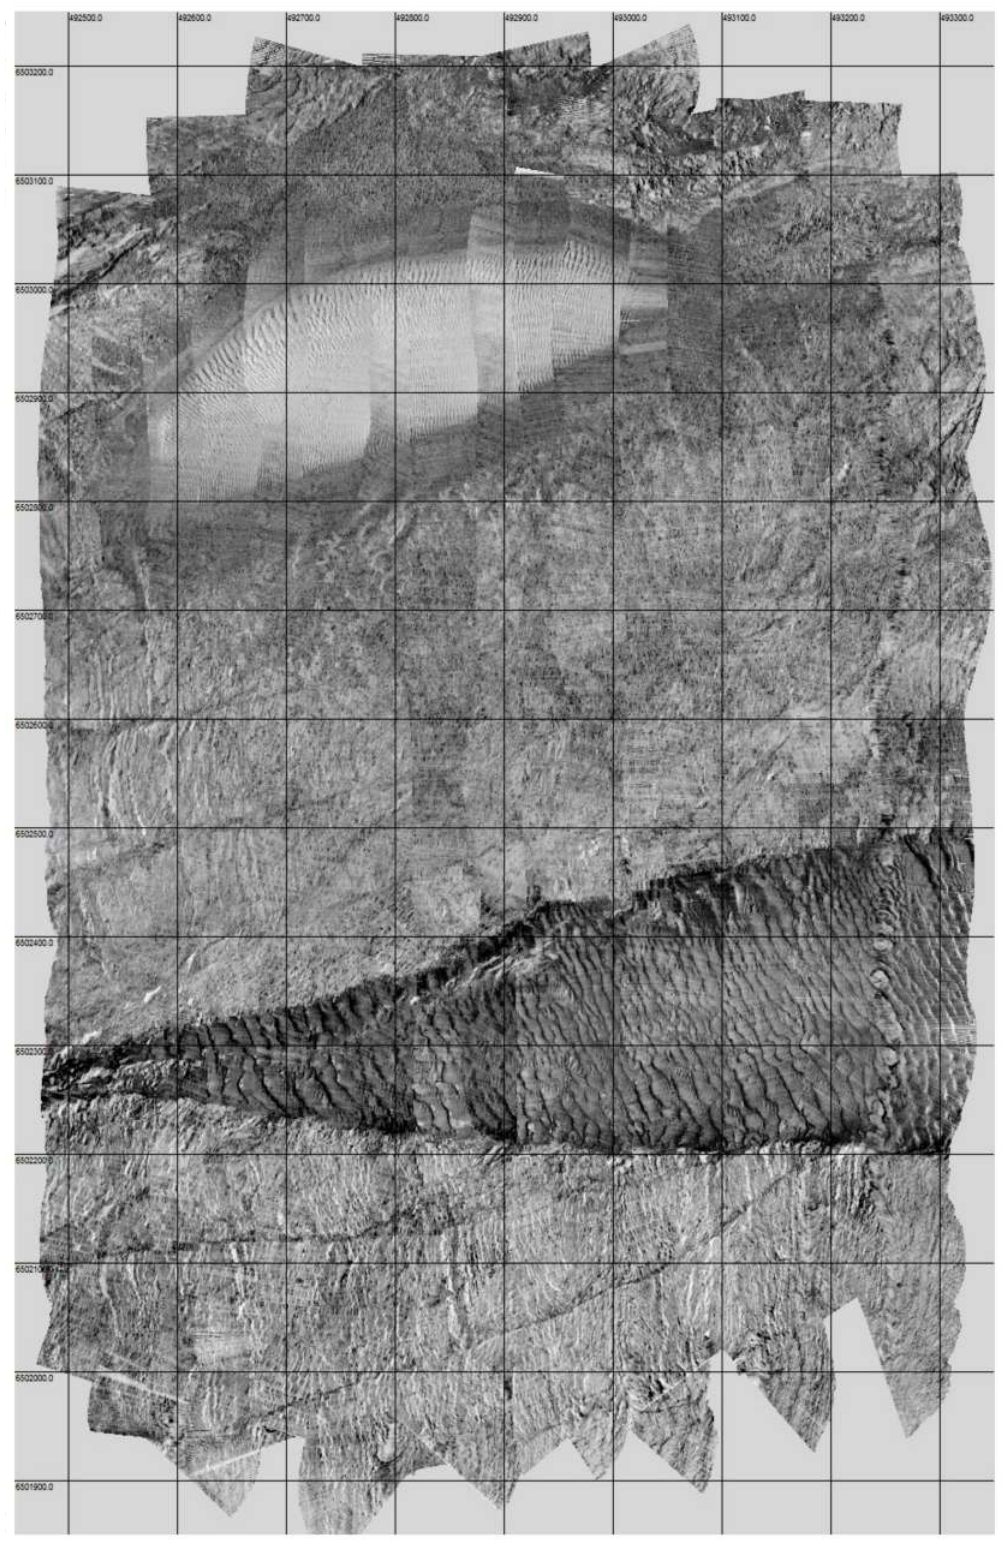
Figure 4. Inner Sound, Pentland Firth. A colour sonar backscatter montage reduced to greyscale. Fifteen swaths are overlain from west to east (ensonification to the west). The grid lines are spaced at 100 metre